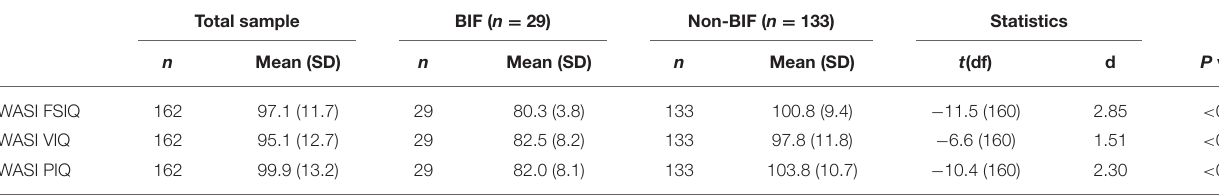
TABLE 2 | WASI scores in the total sample stratified according to intellectual functioning. Total sample